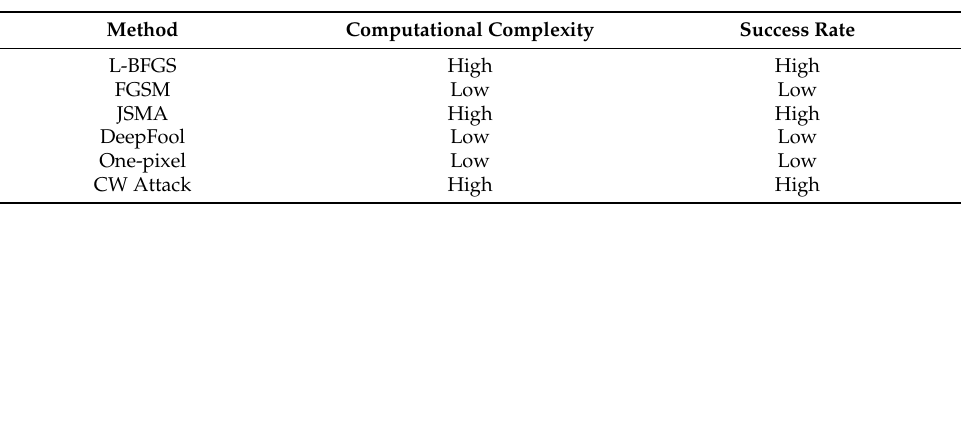
Table 6. Computational complexity of common adversarial example